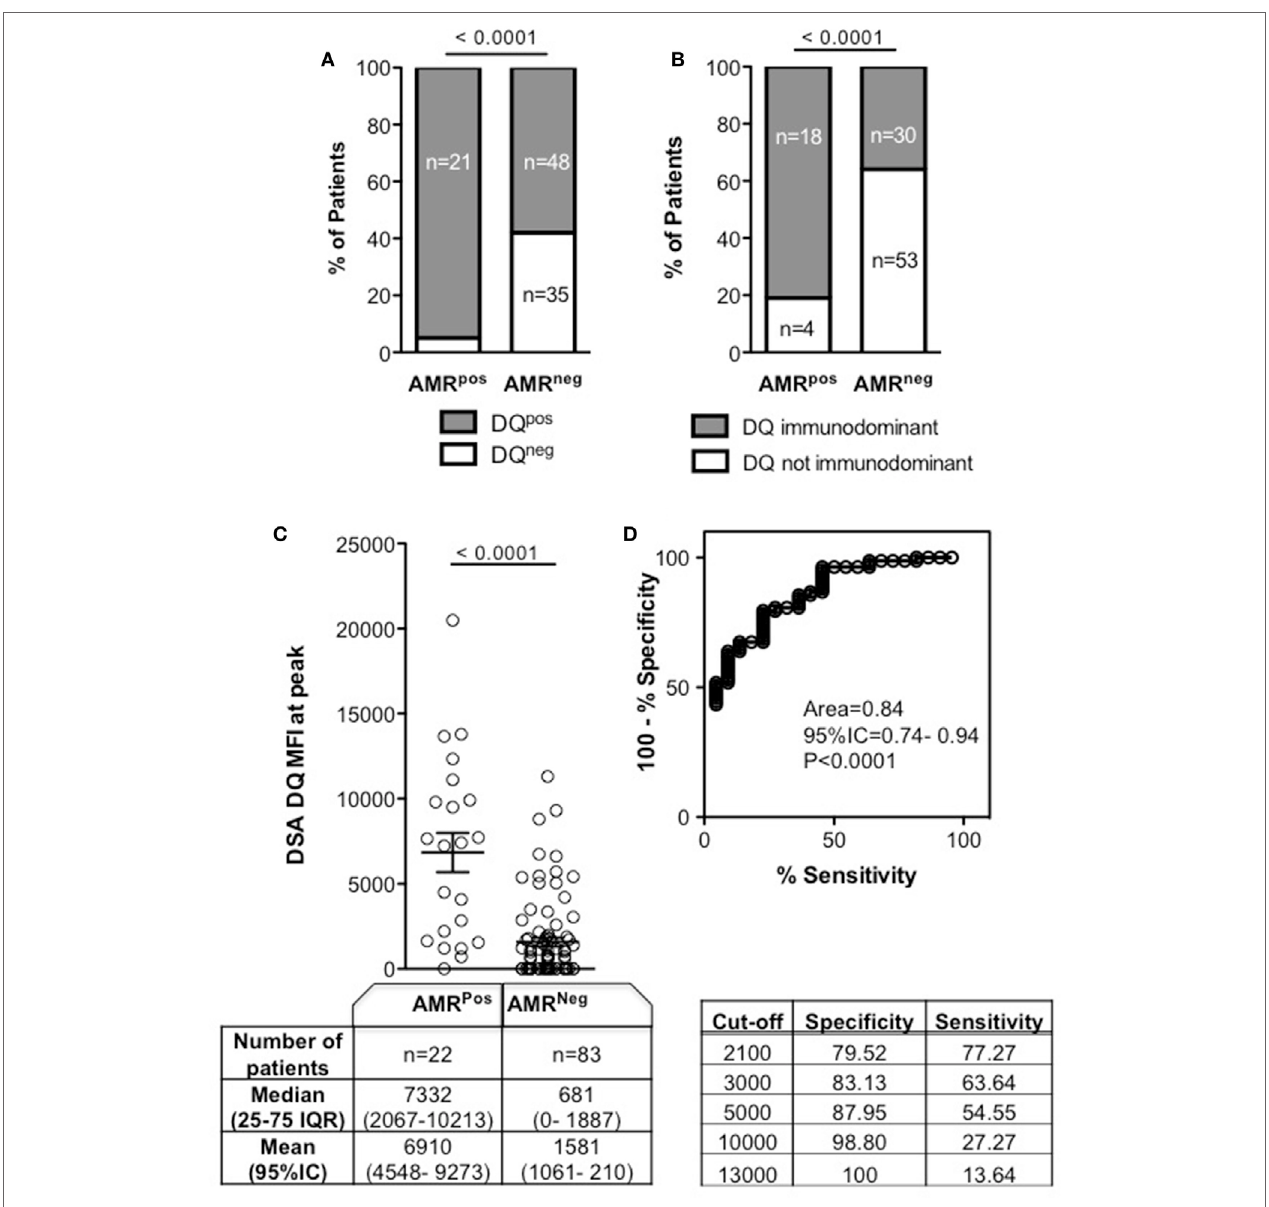
FigUre 4 | DQ mean fluorescence intensity (MFI) of donor specific antibody (DSA) at peak according to antibody-mediated rejection (AMR) status. Peak was defined as the time point of DSA with the highest sum MFI for AMR Neg (DSA Pos AMR Neg ) patients, or as the time of AMR diagnosis for AMR Pos patients. (a) Frequency and number of patients with DQ DSA at the peak. (b) Frequency and number of patients with immunodominant DQ DSA at the peak. (c) Each patient’s DQ DSA MFI are represented as a circle. Comparison of number of patients, as well as median and mean DQ DSA MFI, for AMR Pos and AMR Neg patients is in the table below. (D) ROC curve for use of DQ DSA MFI as a predictor of AMR diagnosis and the specificity/sensitivity according to different MFI cutoffs. Groups were compared using Chi-square (a,b) and Mann–Whitney tests (c) and significance values are denoted above lines over compared